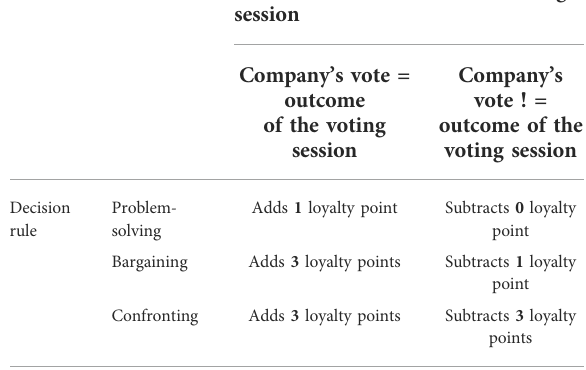
TABLE 3 Assessing the loyalty points.